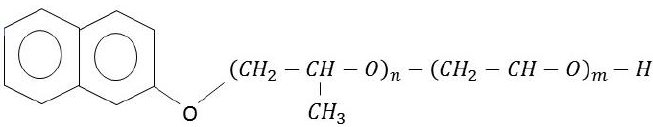
Figure 2. Alkoxylated β -naphthol (ABN) structural equation.